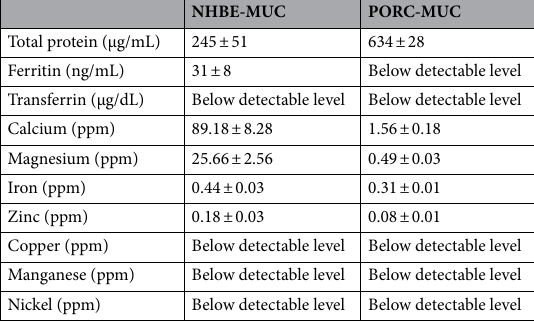
Table 1. Composition of mucus from NHBE cultures and porcine